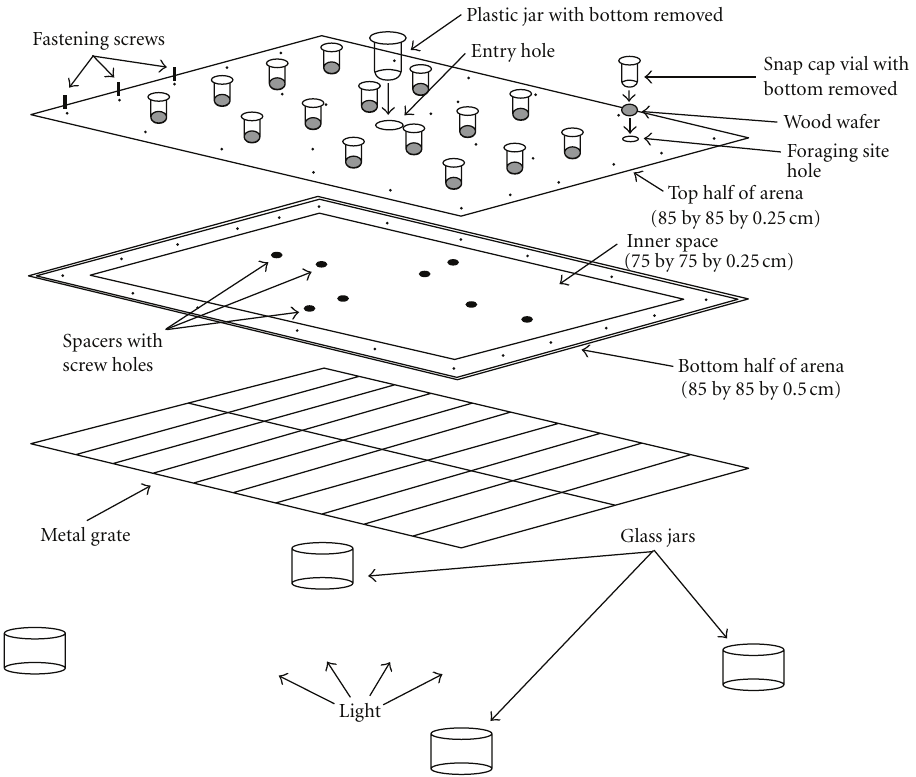
Figure 1: Schematic drawing of a subterranean termite foraging arena, after Campora and Grace [22]. Inner space between top and bottom halves of the arena is filled with moist silica sand.